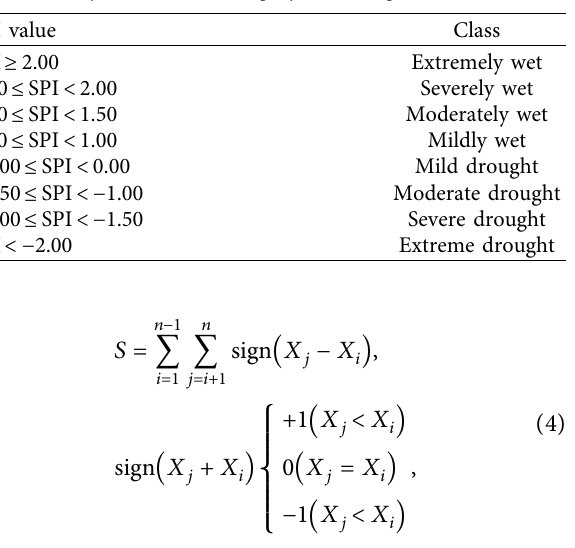
Figure 1: Geographical distribution of meteorological stations used in the Table 2: Dryness/wetness category according to SPI value [6].